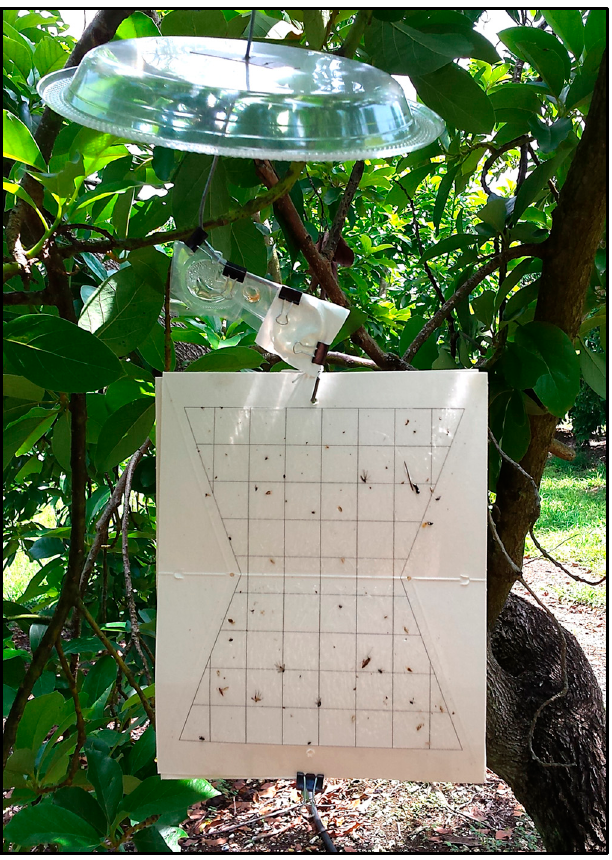
Figure 1. Field trap design. Traps for Euwallacea perbrevis were constructed from two opposing sticky panels hung from a wire hook with bubble dispensers clipped above the panels. Dispensers, from left to right, are piperitone, quercivorol, and α -copaene.